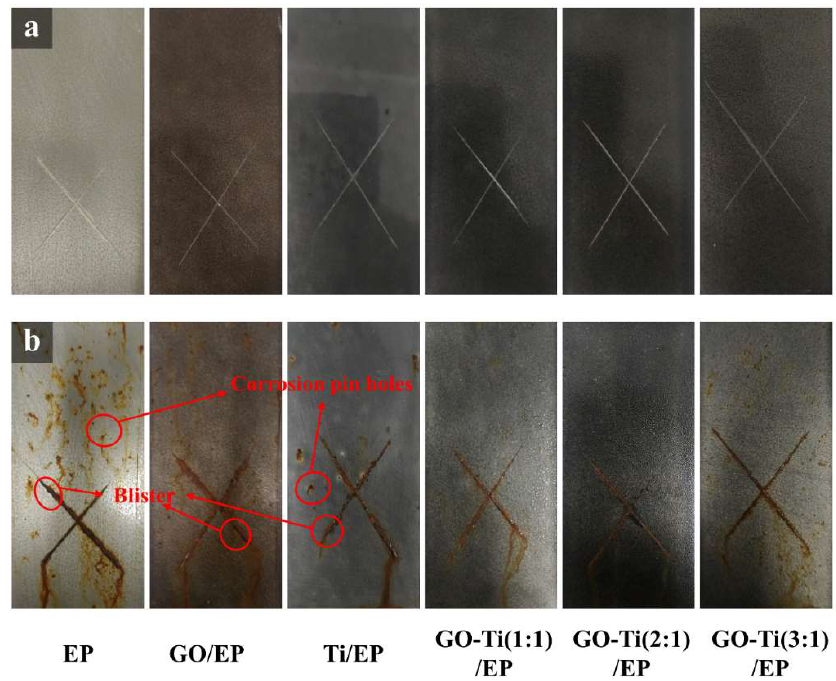
Figure 10. Photographs of different coating salt spray tests: ( a ) Before the salt spray test, ( b ) 168 h after the salt spray test.